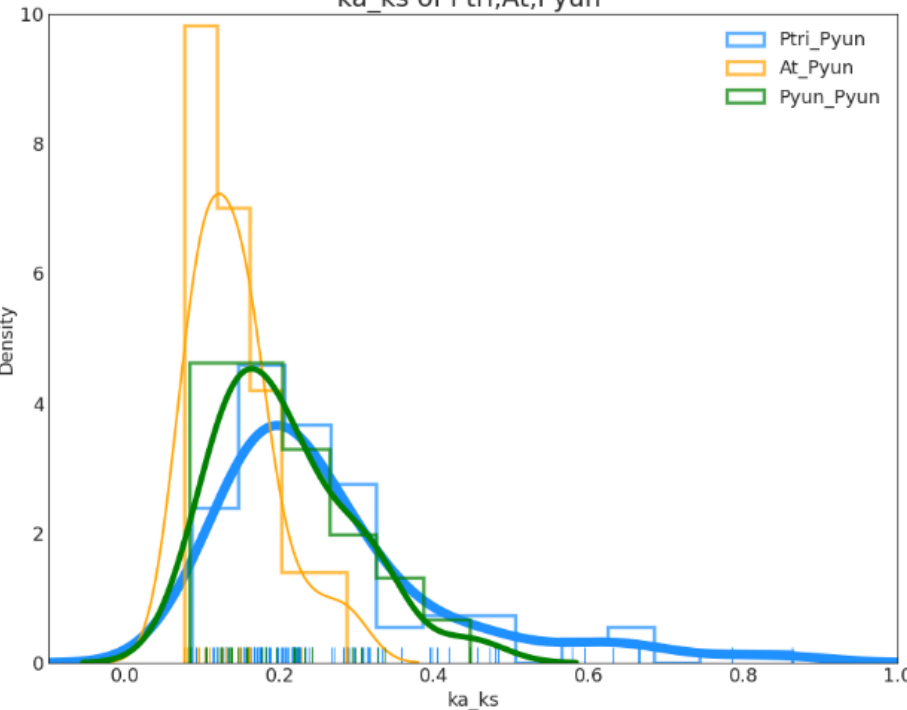
Figure 6. Ka/Ks ratios of collinear PyuARFs in P. trichocarpa , P. yunnanensis , and A. thaliana . Blue curves represent the Ka/Ks ratios of collinear ARF genes in P. trichocarpa and P. yunnanensis . Yellow curves represent the Ka/Ks ratios of collinear ARF genes in P. yunnanensis and A. thaliana . Green curves represent the Ka/Ks ratios of collinear ARF genes in P. yunnanensis and P. yunnanensis. 3.5. Prediction of Cis-Regulatory Elements in the Promoters of PyuARFs We then studied the potential regulation of cis-acting elements in PyuARFs expres- sion. We analyzed 2 kb promoter sequences of PyuARFs. We found that MeJA (CGTCA motif), light-responsive (Box4), ABA (ABRE) anaerobic (ARE), gibberellin (GARE motif) motifs and response elements were abundant in the promoters of PyuARFs ; salicylic acid (TCA motif), MYB drought (MBS), auxin (AuxRR core), low temperature (LTR), endo- sperm and meristem (GCN4), and circadian response elements were also found in the promoters (Figure 7).